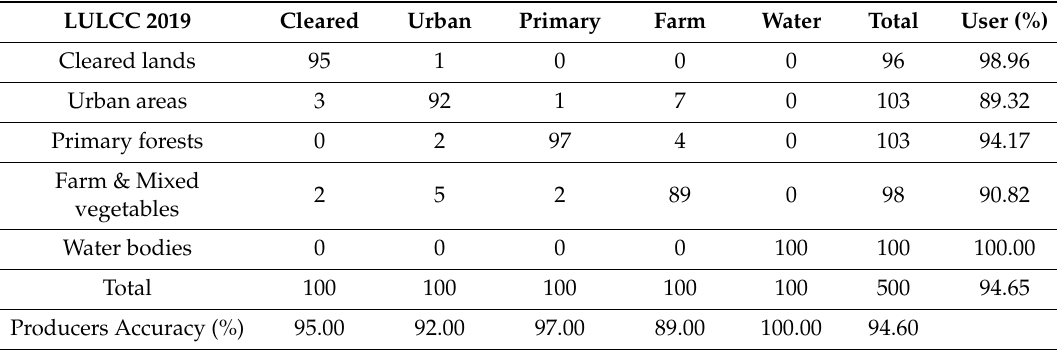
Table 6. Confusion matrix table of 2019 land cover classification.